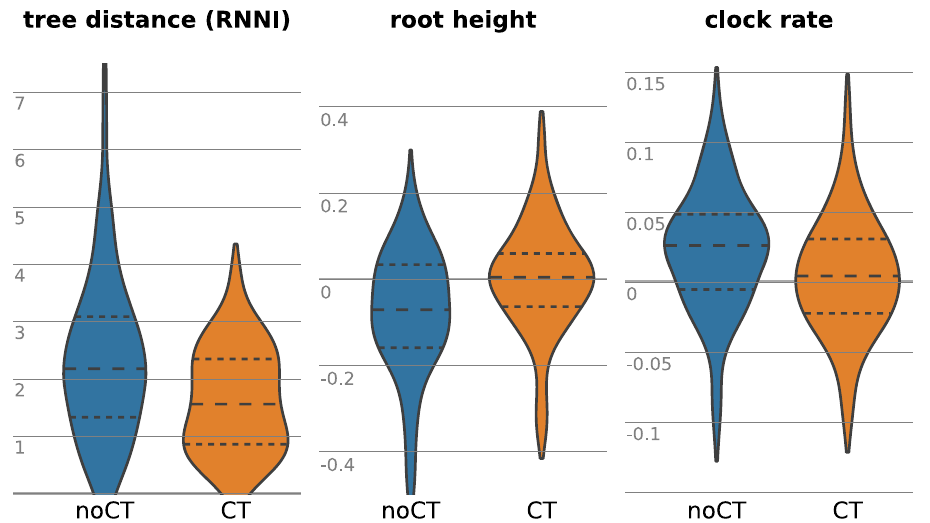
Fig. 4 The error distribution for the tree topology, root height and clock rate, respectively, in the simulation study. For a conventional phylogenetic model (noCT, blue), the error is larger than for the contacTrees model (CT, orange).